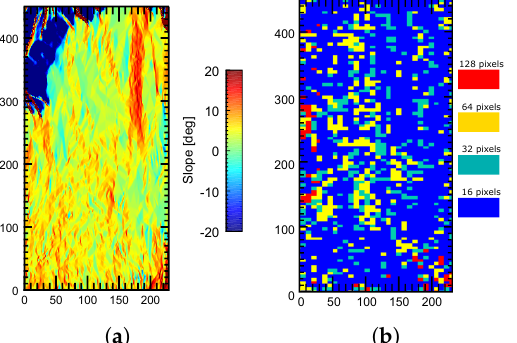
Figure 21. Filtering window sizes providing the best results in an area where strong terrain slopes are present. ( a ) Local terrain slopes in the region of interest. ( b ) Window sizes providing the best filtering results in the region of interest A.